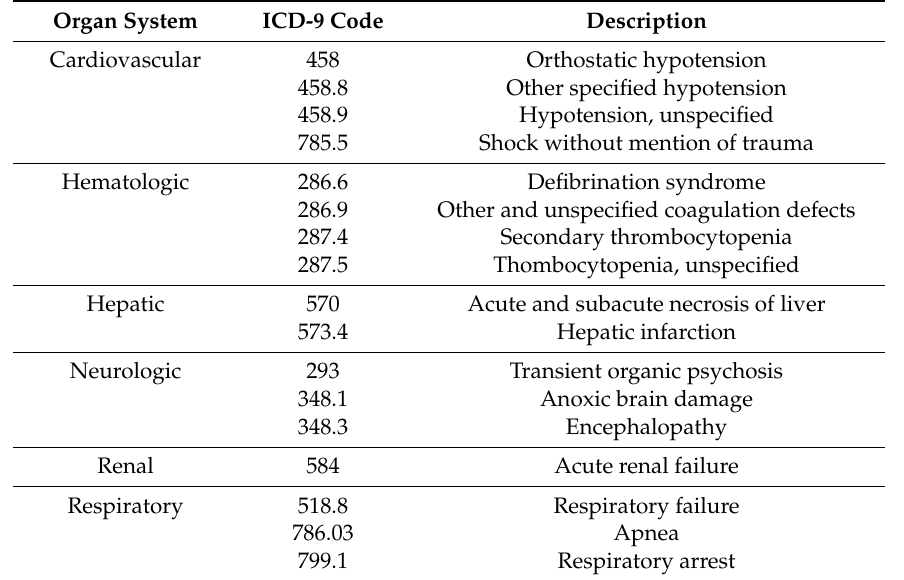
Table A3. Angus, et al. ICD-9 codes for organ dysfunction